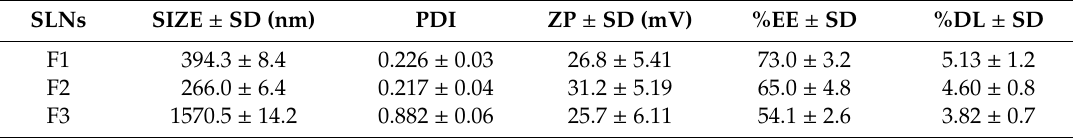
Table 1. Particle characterization of the solid lipid nanoparticles